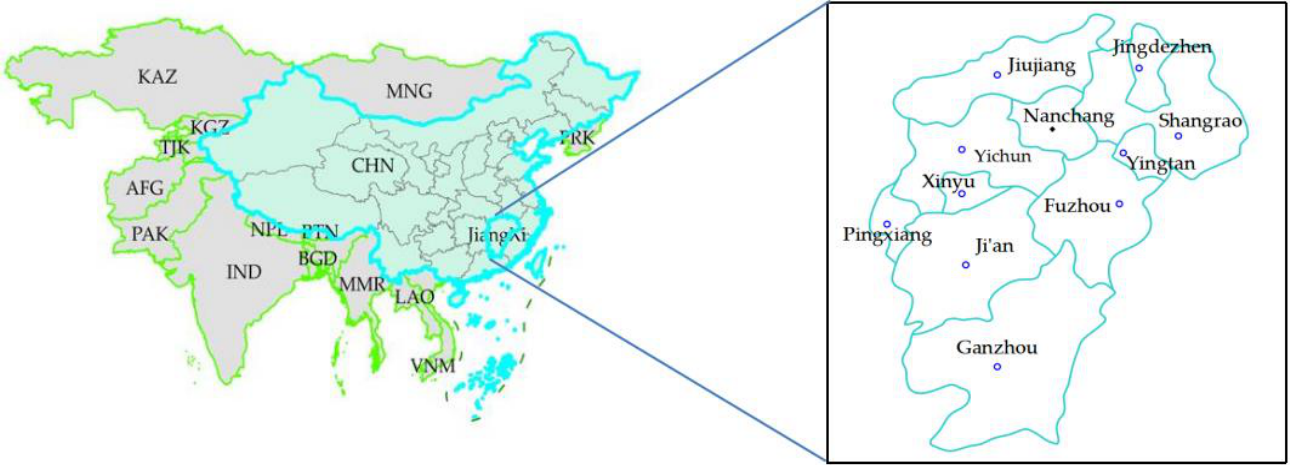
Figure 1. Map of Jiangxi Province, China. Note: KGZ: Kyrgyzstan, AFG: Afghanistan, NPL: Nepal,